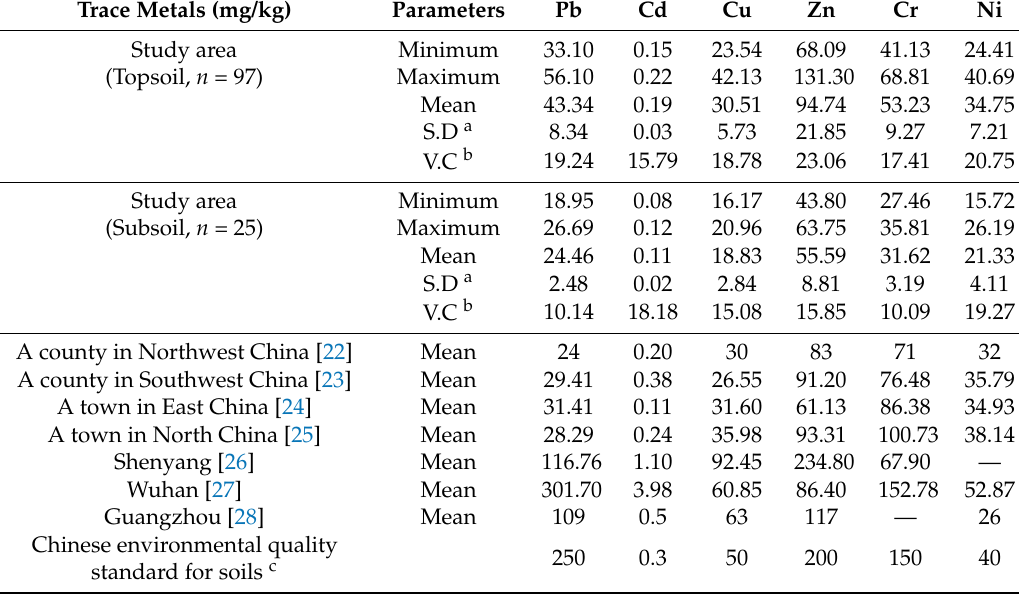
Table 1. Descriptive statistics of trace metal concentrations in the topsoil and subsoil.